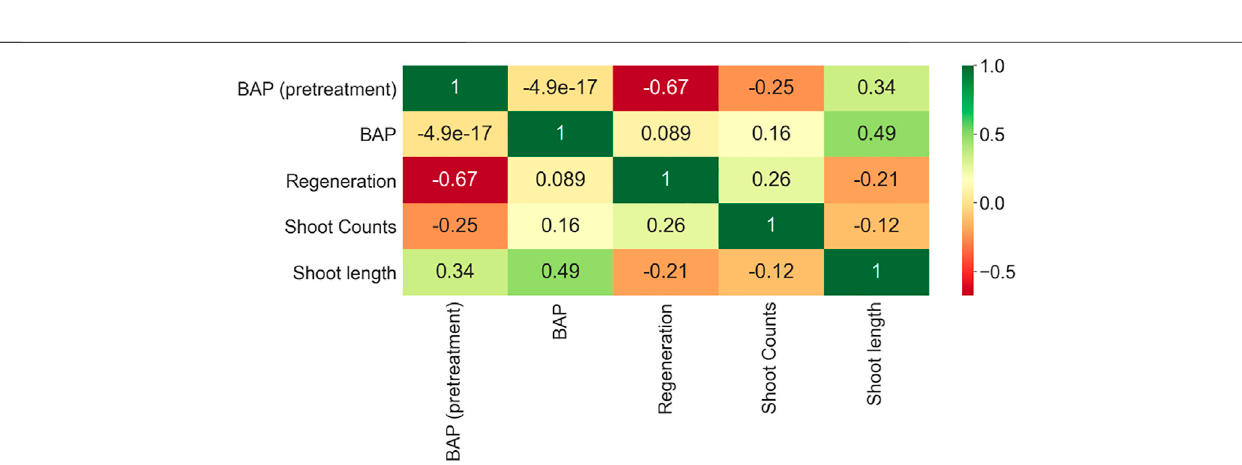
FIGURE 7 | Correlation matrix of inputs and outputs for common